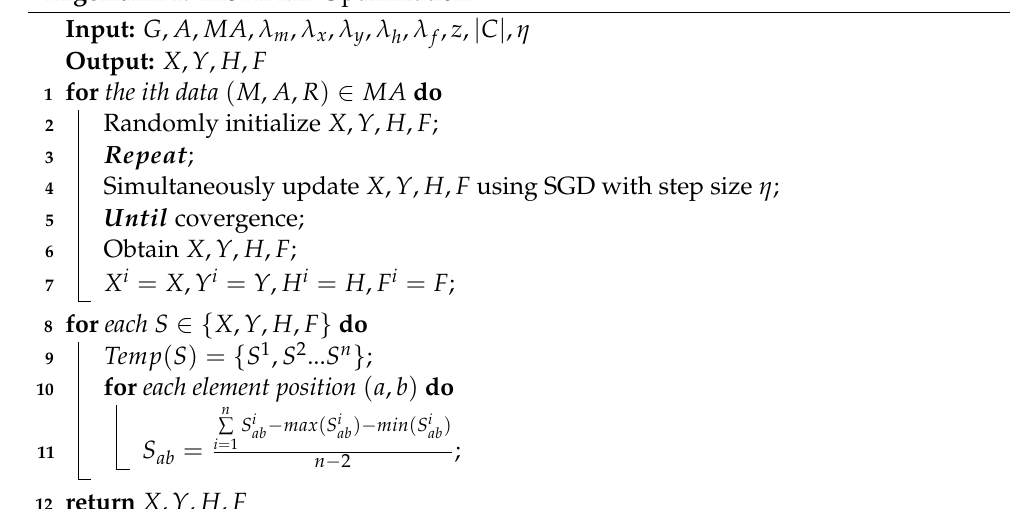
Algorithm 1: The ABMF